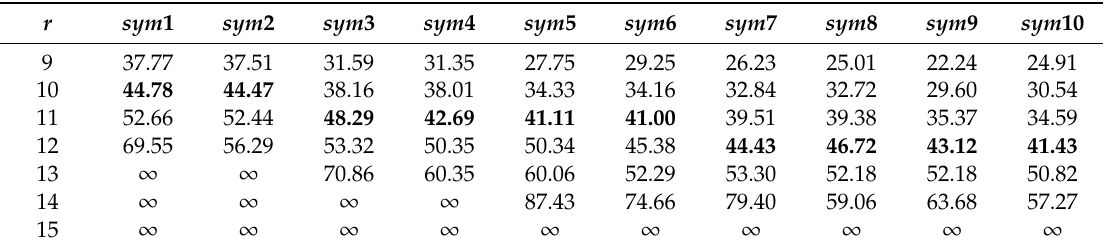
Table 19. Experimental results ( PSNR , dB) of 3D tomographic 8-bit image “wmri” DWT by using bit-width r of symlets filters coe ffi